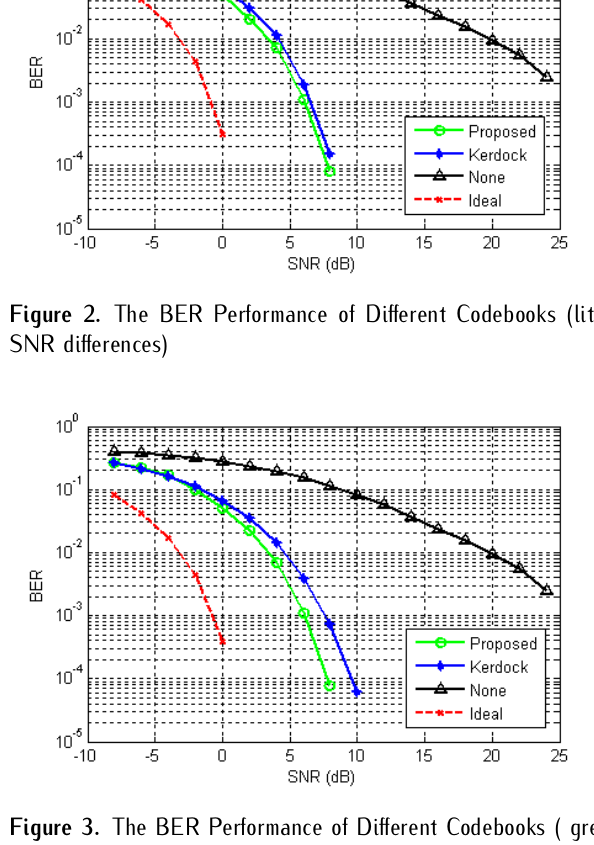
Figure 3. The BER Performance of Different Codebooks ( great SNR